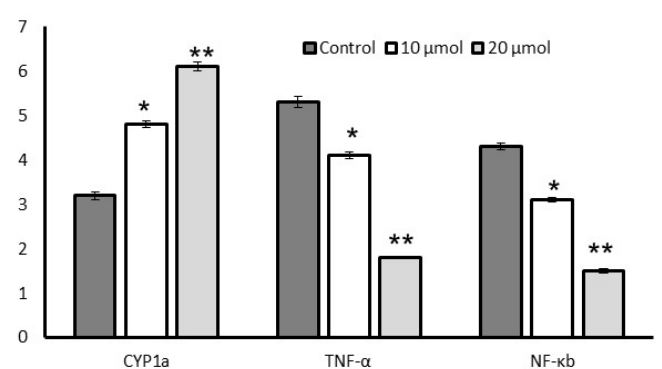
Figure 7. Effect of lut-7 -O- rutinoside on CYP1a, TNF- α , and NF- κ b expression levels in RIN-5F cells. Each value is presented as the mean ± SD for 6 replicates. *: p ≤ 0.05 and **: p ≤ 0.001, lut-7 -O- rutinoside-treated RIN-5F cells, as compared with the control.